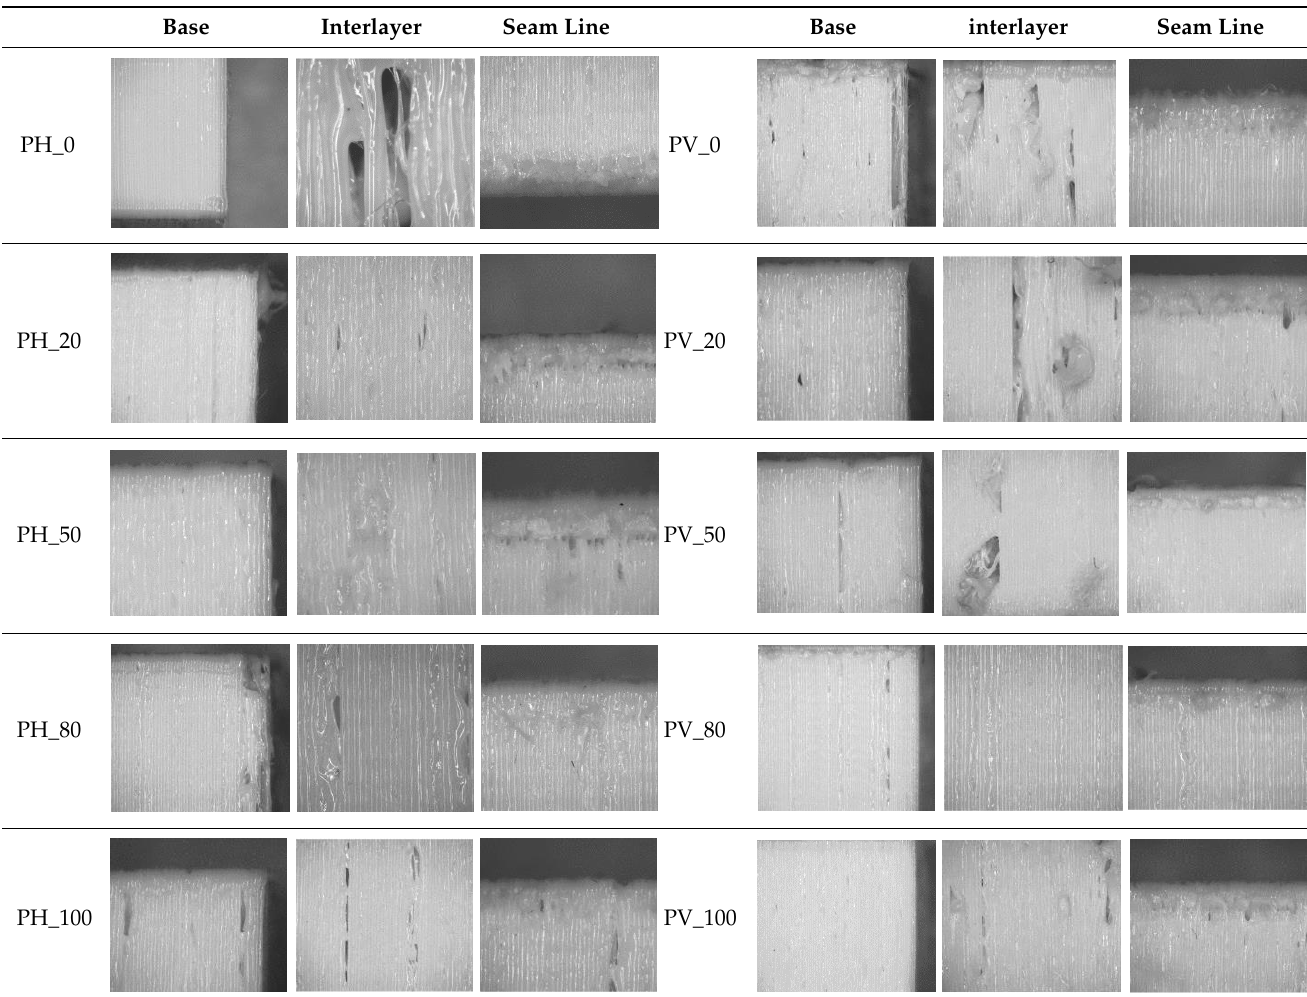
Table A1. Optic microscopy of prismatic specimens.